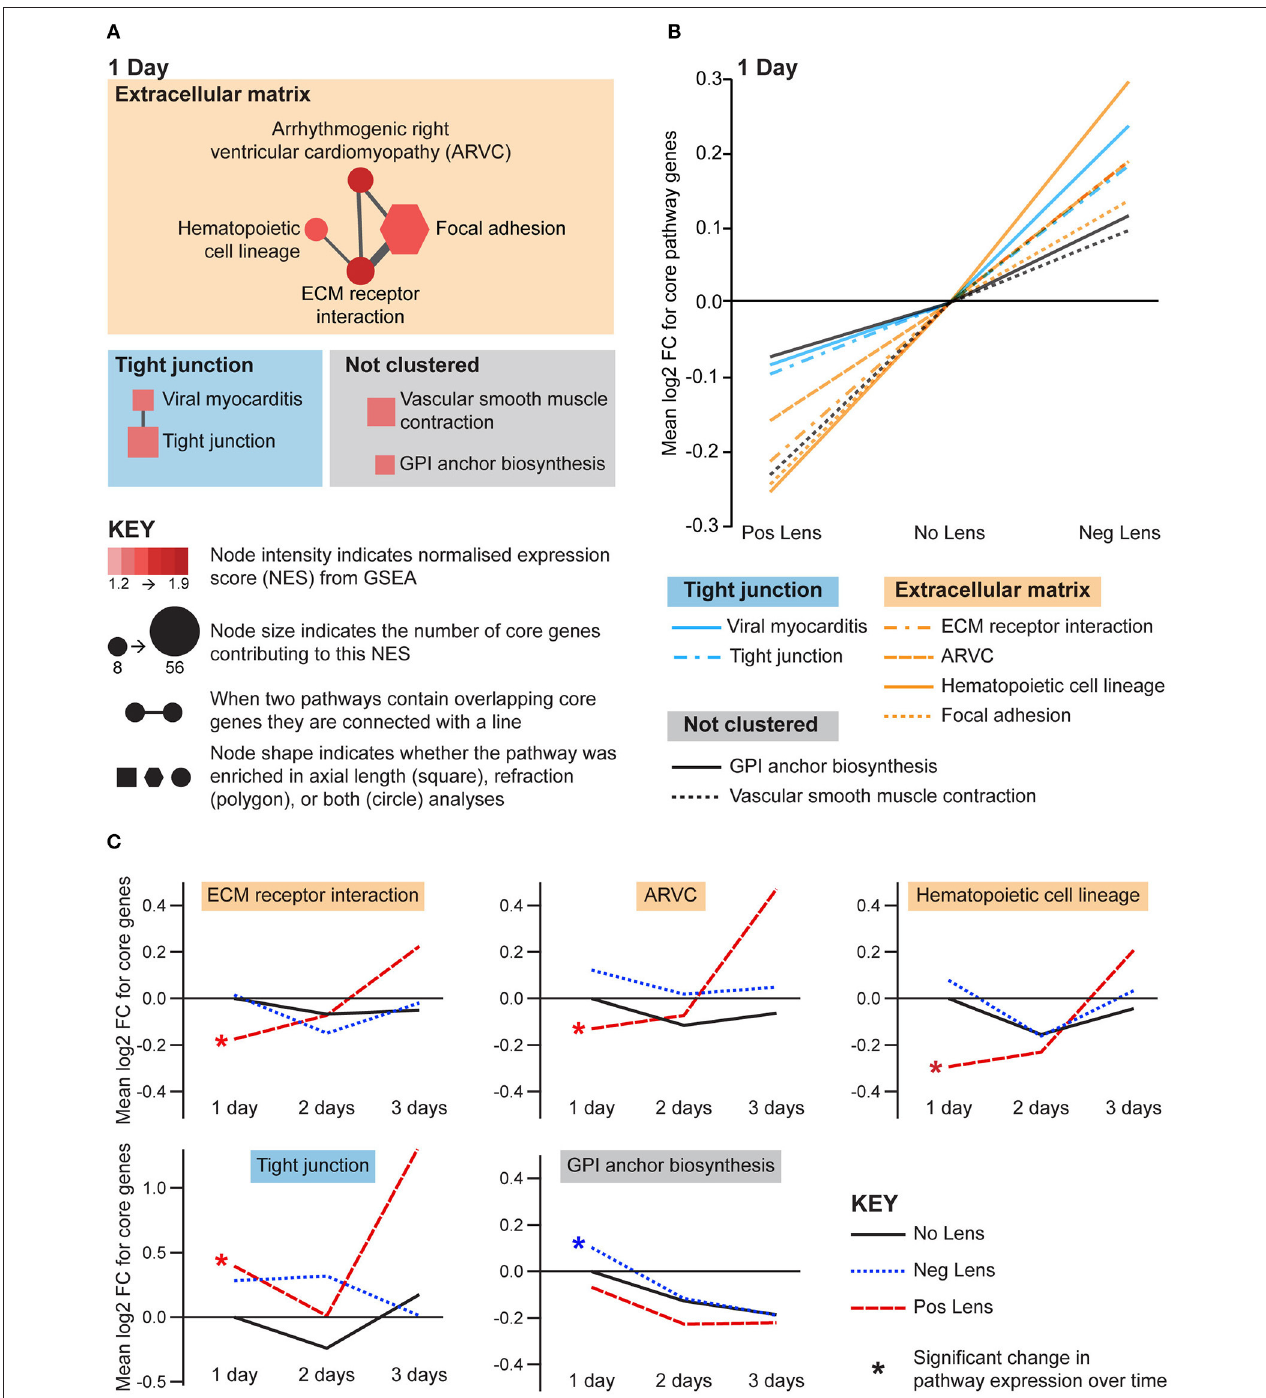
FIGURE 5 | Structural pathway expression changes during refractive compensation, and normal development. (A) Network diagrams showing structural pathways positively correlated with eye size on day 1. Each node represents a pathway, and nodes are connected with a line when two pathways contain common core genes (representing related biological processes; thicker lines = more overlap). Node color indicates the direction of expression change (red = positive correlation with axial length and/or negative correlation with refraction). Node intensity indicates the normalized expression score (NES) from the axial length analysis (circle and square nodes) or the refraction analysis (polygon nodes). (B) Line graph showing mean log2-fold change for the core genes responsible for each pathways’ enrichment. Note that this graph indicates that enrichment results were driven by roughly proportional expression shifts in both lens groups. (C) Structural pathways from “A” also showing expression changes across time within lens groups. Line graphs show the mean log2-fold change for core genes relative to the 1 day No Lens group. Note that because the core genes responsible for pathway enrichment vary for within and across group analyses, these values differ from those shown in “B”. For full details of GSEA results see Supplementary Tables S10,